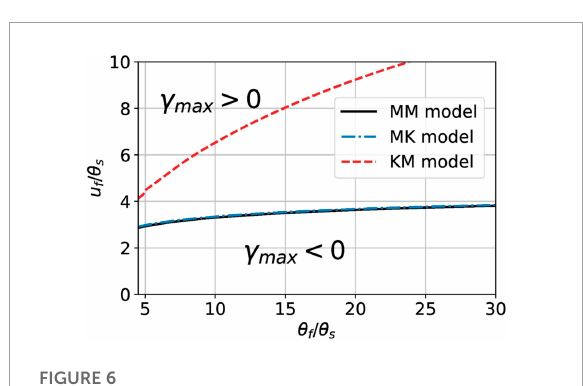
FIGURE 6 EAI threshold of the relative drift u f / θ s for different MPS ratios θ f / θ s in three models. The fraction of slow-MPS electrons n s / n 0 = 0 . 5 is fixed in this